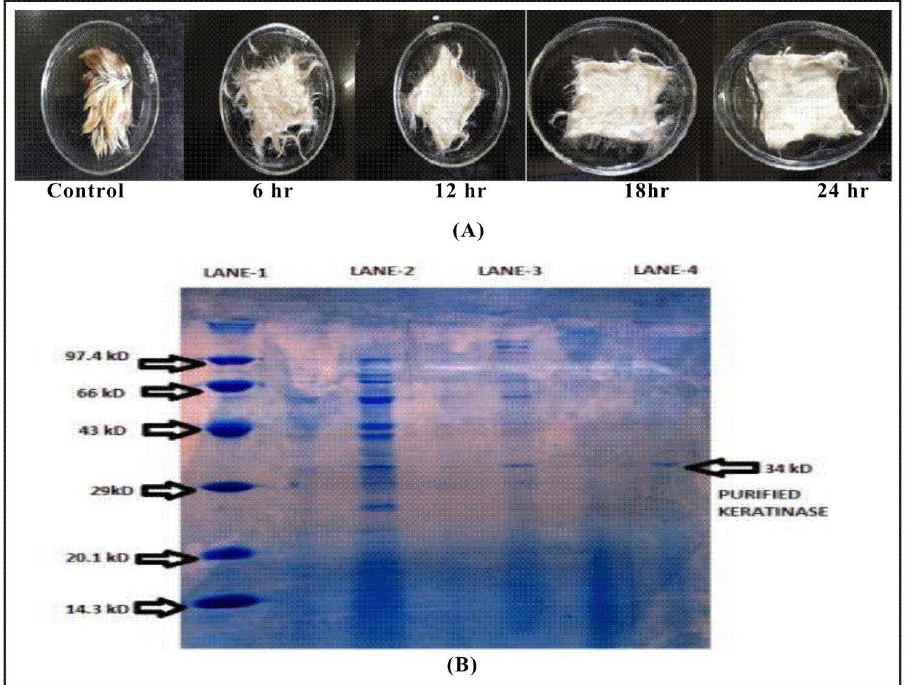
Fig. 2. (A) Goat skin treated with crude keratinase (B) electrophoresis of purified keratinase; protein marker-lane 1, crude protein - lane 2, protein after ammonium sulfate precipitation- lane 3, purified keratinase enzyme (lane